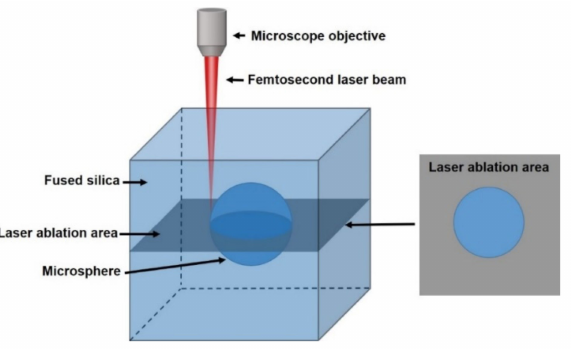
Figure 1. A schematic diagram of laser processing (the gray part is the femtosecond laser ablation area).